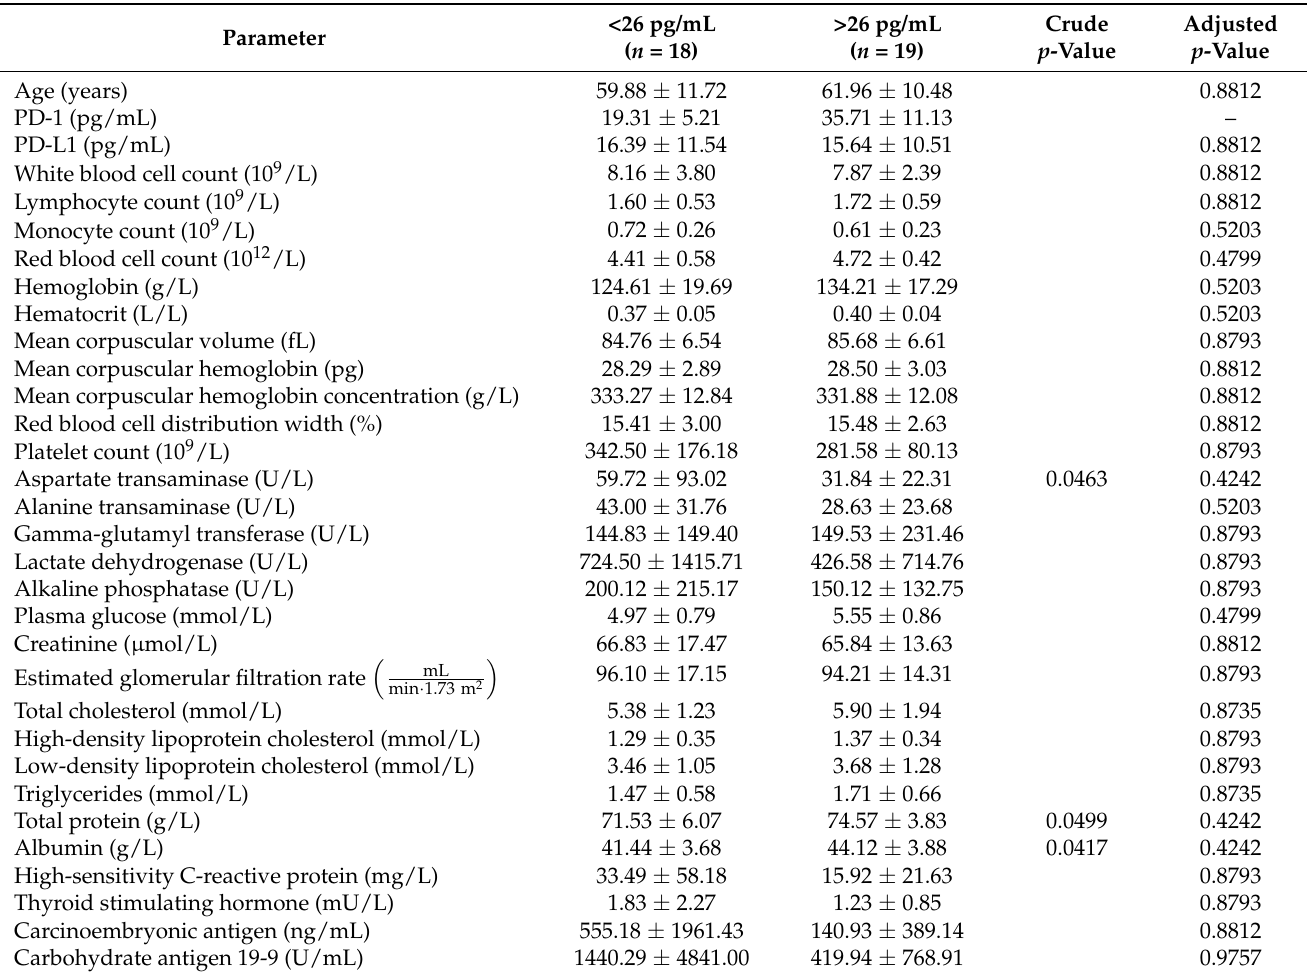
Table 5. Comparison of age and laboratory measurements for study participants with plasma PD-1 levels under or over 26